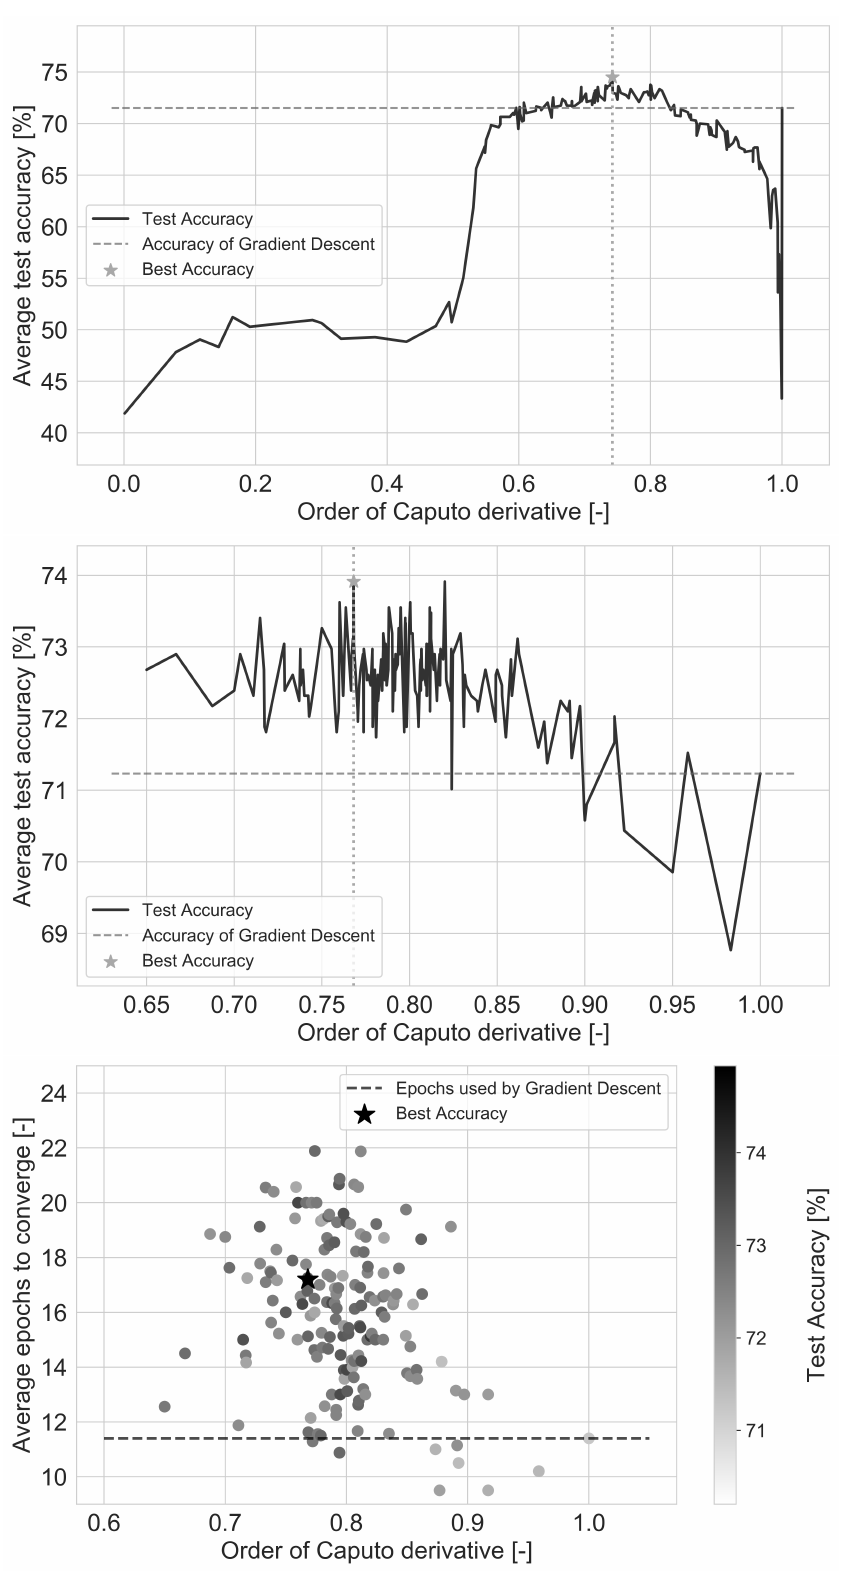
Figure 6. Average test accuracy of the two PSO runs, and the average training epochs taken to reach Gradient Descent’s accuracy for the second run (from top to bottom) on the Liver